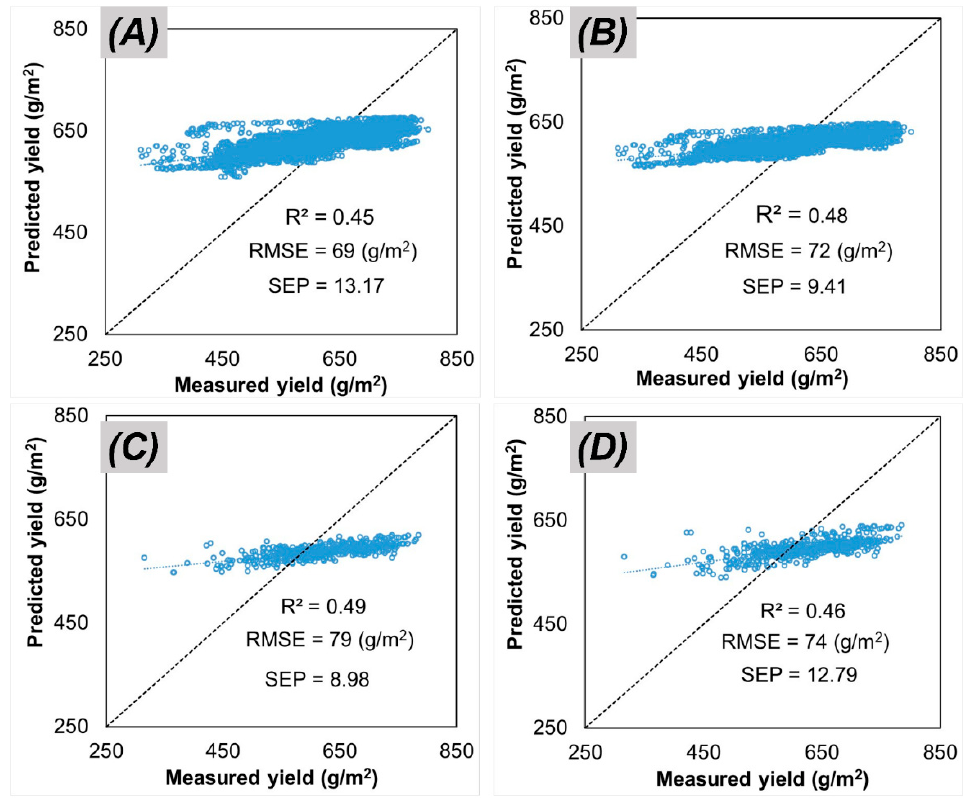
Figure 9. Comparison of predicted and measured wheat yield representing three scenarios evaluating the impact of spatial and temporal resolution. ( A ) original PS-S2 MSAVI fused image (55 images throughout the season); ( B ) reduced temporal resolution: The number of images used was reduced to resemble the Sentinel-2 revisit time (10 images throughout the season); ( C ) reduced temporal and spatial resolution: the number of images used was reduced to resemble the Sentinel-2 revisit time (n = 10), and images were resampled to the Sentinel-2 spatial resolution of 10 m; ( D ) reduced spatial resolution (n = 55): The images were resampled to the Sentinel-2 spatial resolution of 10 m.